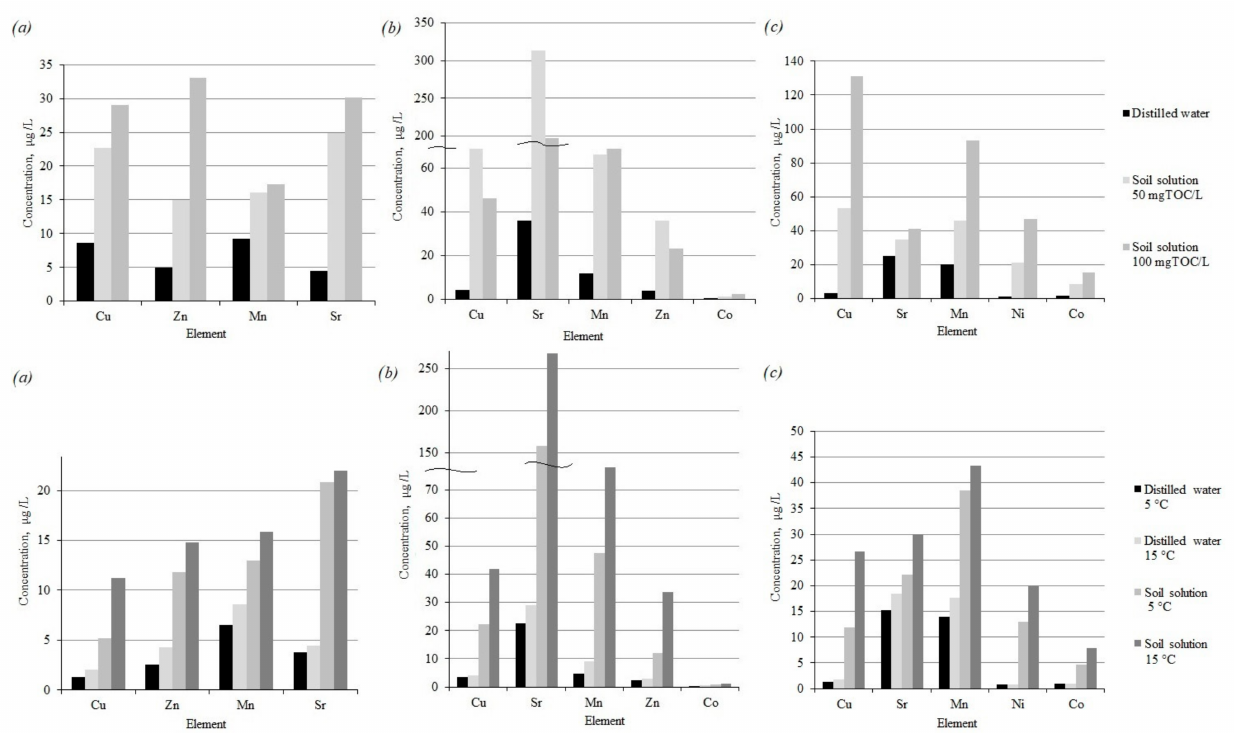
Figure 4. Concentrations of HM in the resulting solutions after five hours of interaction of enrichment tailings of loparite ( a ), apatite-nepheline ( b ) and complex ( c ) ores with distilled water and water extracts of